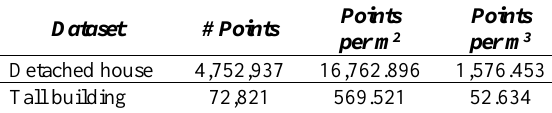
Table 2. Number and density of points in each PolyFit dataset.